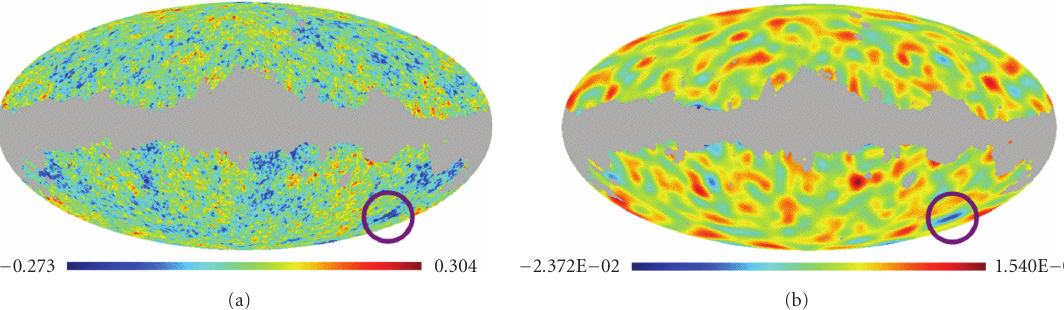
Figure 3: (a) CMB cleaned map derived from the 4th release of the WMAP data, obtained via the template fitting technique described in [75]. (b) wavelet coe ffi cients of the previous map, obtained after the SMHW convolution at a scale of R = 250 arcmin. The location of the Cold Spot is indicated in both panels by the circle. The centre of the Cold Spot is θ = 147 ◦ and φ = 210 ◦ .